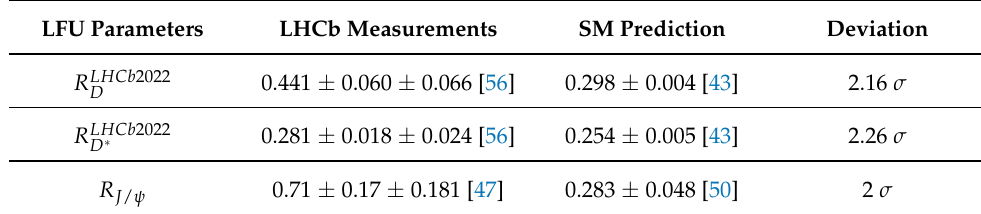
Table 1. Summary of experimental measurements with the SM predictions LFU Parameters LHCb Measurements SM Prediction Deviation R LHCb 2022